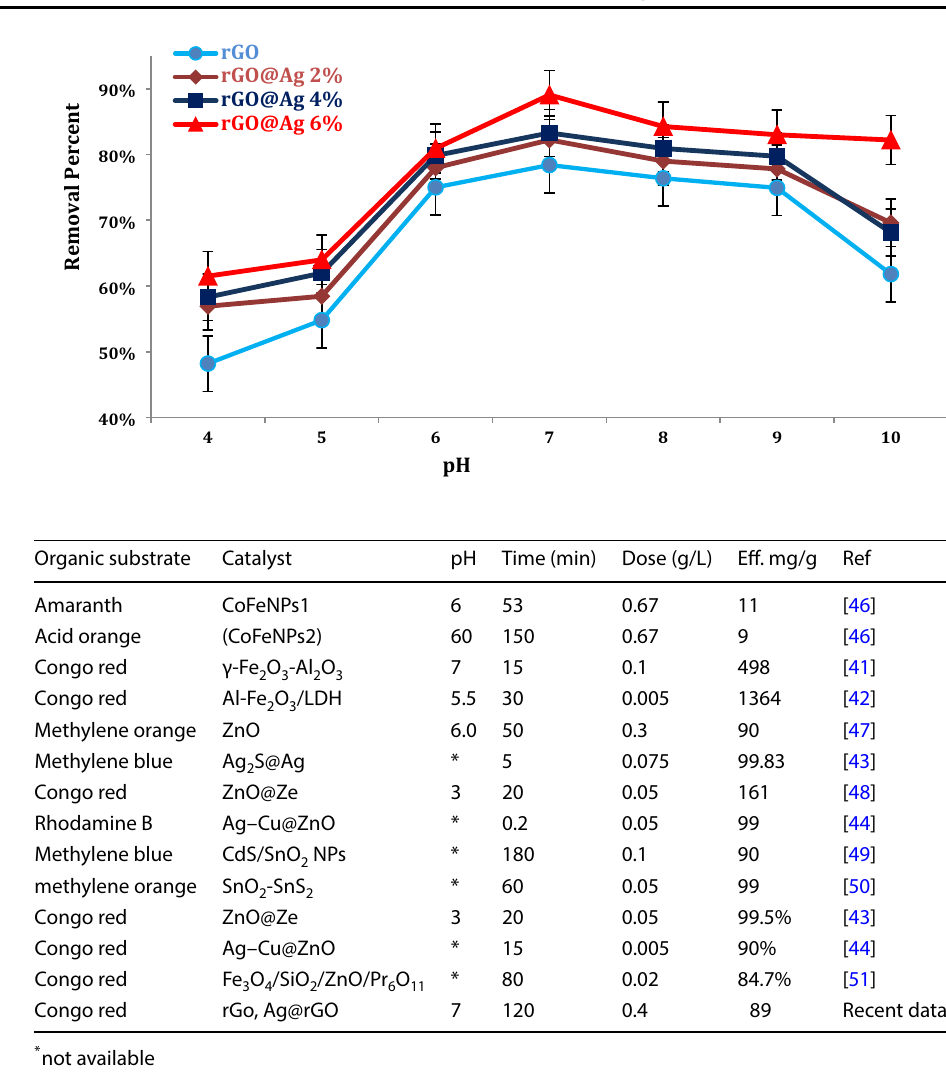
Fig. 9 Photodegradation of Congo red dye under different contact time